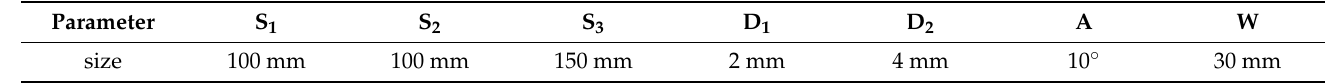
Figure 2. Energy-absorbing specimen with variable buffer force. ( a ) Three-dimensional axonometric view; ( b ) schematic diagram of parameters. Table 1. Cutting parameters of the test piece.